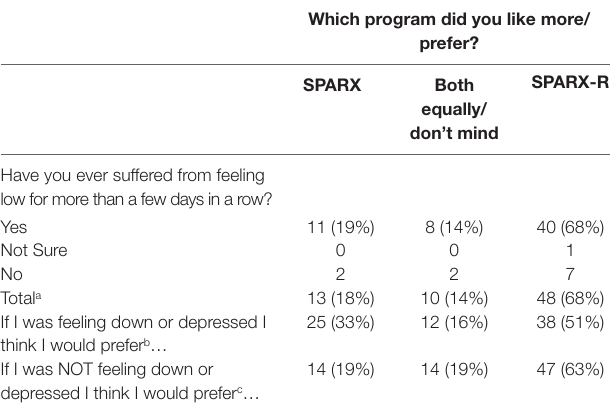
TABle 5 | Questionnaire